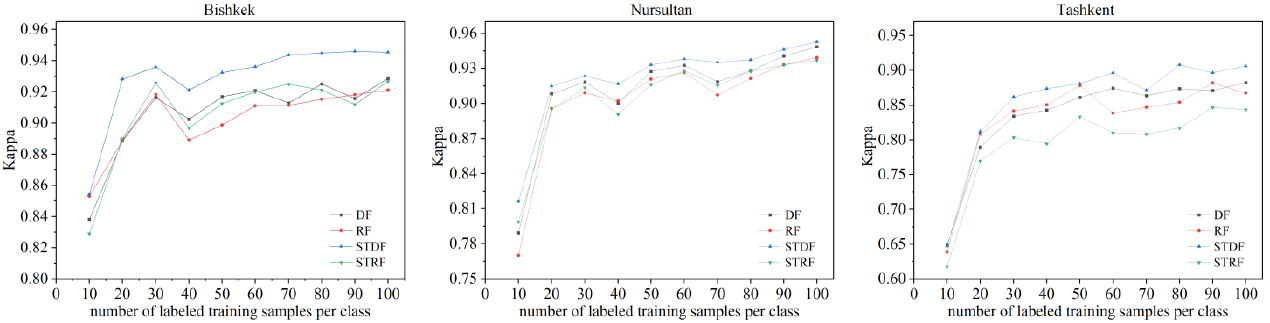
Figure 4. Kappa coefficients for four strategies using different numbers of training samples for the study areas.